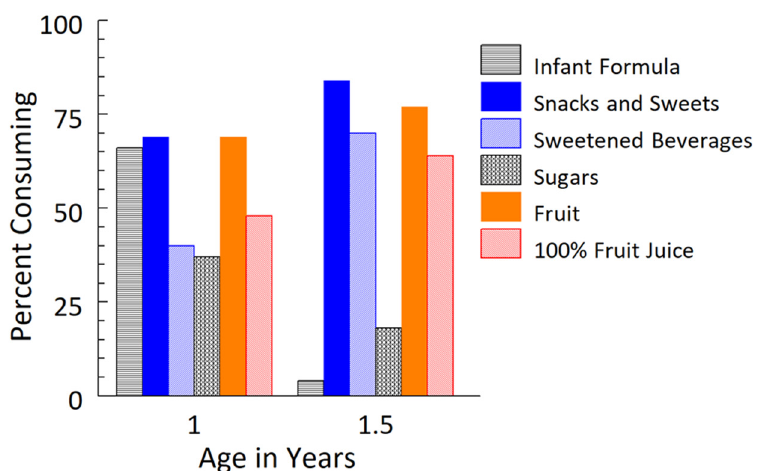
Figure 1. Percentages consuming selected What We Eat in America (WWEIA) food categories at 1